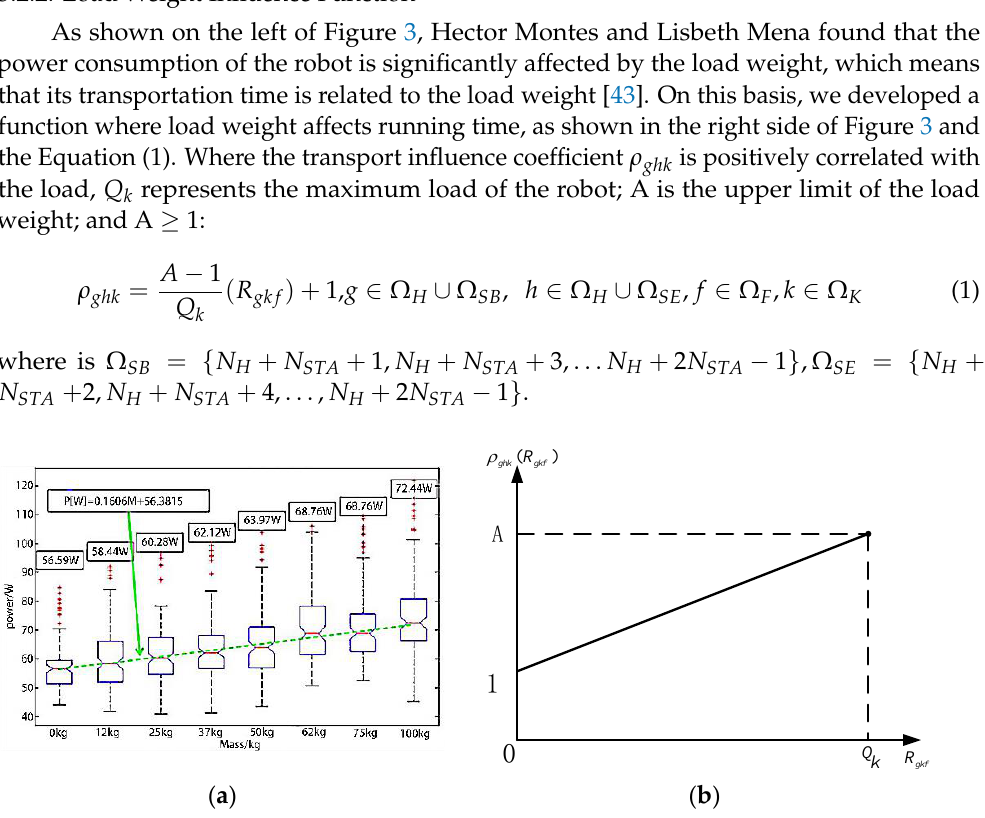
Figure 3. Study on the influence of load weight. ( a ) Relationship between power and load; ( b ) Relationship between transport capacity factor and load.